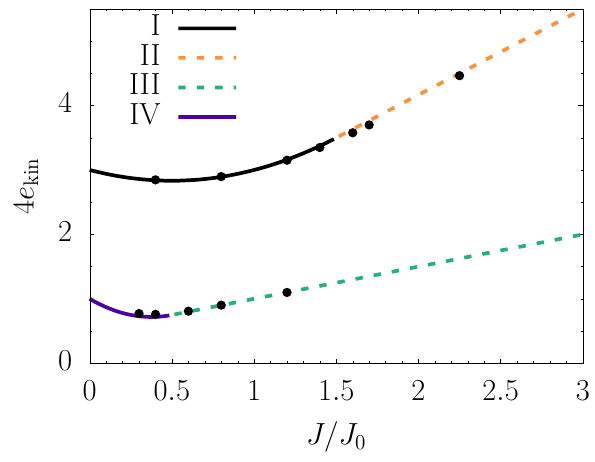
Figure 10: Test of the harmonic Ansatz within the GGE calculation. The kinetic energy density as a function of J / J for two values of the initial temperature T 0 of the initial conditions. The black dots are numerical results obtained with the har- monic Ansatz for the evaluation of the GGE and the curves represent the exact values / J = 1.5 (above) and T / J = 0.5 for T 0 0 0 0